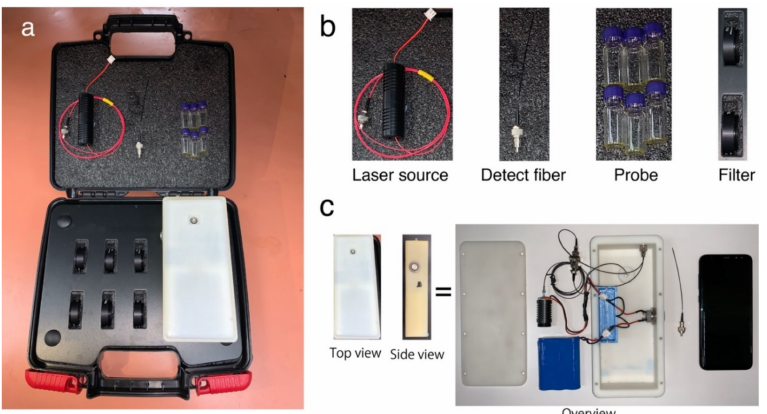
Figure 1. Illustration of an SOFS kit for the determination of ethylene concentration in air. ( a ) Overview of the SOFS kit. ( b ) Components of the SOFS kit. ( c ) Illustration of internal com- ponents consisting of battery, excitation source, bifurcated optical fiber connector, replaceable fiber optic and smartphone.